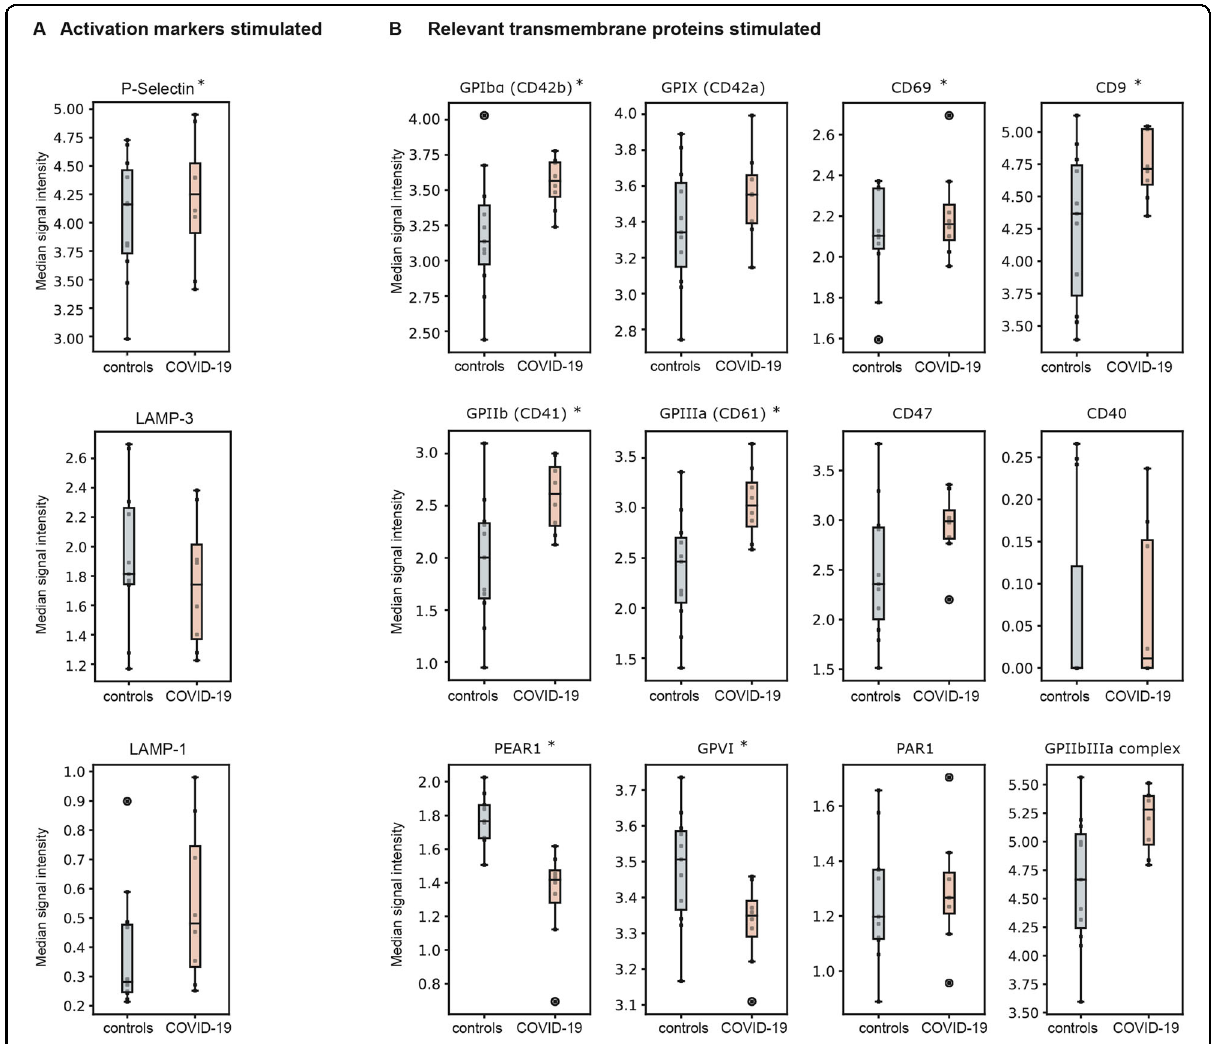
Fig. 3 Marker expression in TRAP-stimulated platelets. Median signal intensity of activation markers ( A ) and relevant transmembrane proteins ( B ) in TRAP-stimulated platelets (10 µM TRAP). COVID-19 patients are plotted in red, whereas controls are plotted in blue. The horizontal line within the box plot represents the median, the top and bottom the interquartile range (Q1 – Q3), whisker bars indicate the largest observation that is less than or equal to the upper inner fence (UIF = Q3 + 1.5 × IQR) or the smallest observation that is greater than or equal to the lower inner fence (LIF = Q1 – 1.5 × IQR) and the circles indicate outliers, if present; * P < 0.01. N = 8 COVID-19 patients, 11 healthy